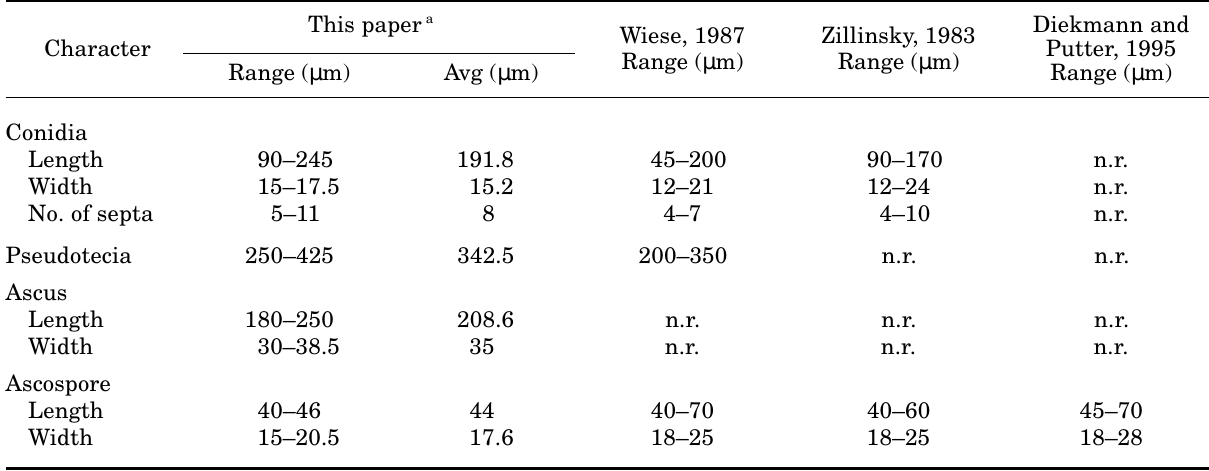
Table 1. Conidia, pseudothecia, asci and ascospores characteristics of the pathogen causing tan spot at two sites in Syria, Efrin and Akhtarin (this paper), as compared with sizes of Pyrenophora tritici-repentis reported in the